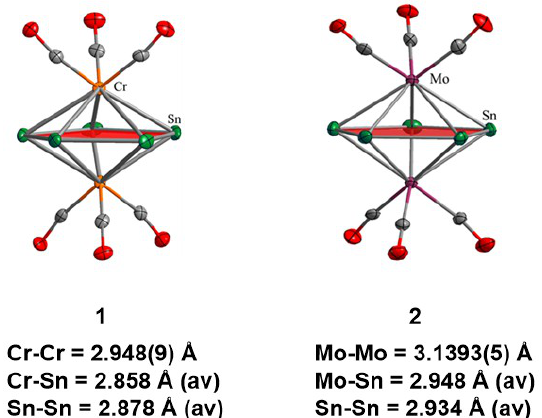
Figure 2. Molecular structure of the anions [(CO) in compounds 1 and 2 , respectively. Thermal ellipsoids are drawn at the 50% probability